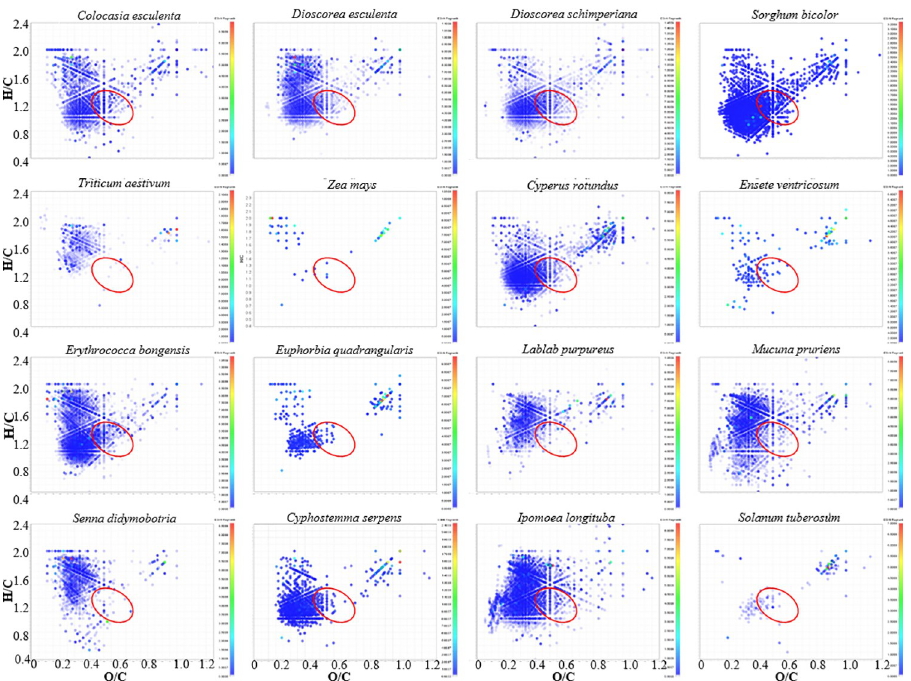
Fig 3. Van Krevelen diagrams illustrating the distribution of Maillard reaction products from hydrous pyrolysis of glycine and starch analysed through FTICR-MS electrospray ionization in negative ion mode. Each dot reflects at least one species. The red circle encompasses species within the ‘island of stability’ observed in refractory dissolved organic matter [66]. The red end of the scale indicates a higher relative abundance of species intensity.